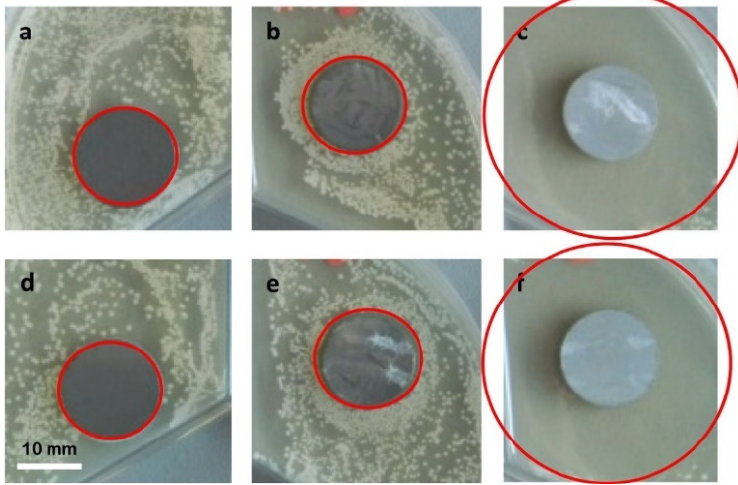
Figure 8. Bacterial inhibition tests after 24 h (direct contact, halo test) for: ( a ) bare SS sample with S. aureus , ( b ) chitosan–gelatin EPD coating on SS with S. aureus , ( c ) chitosan–gelatin-SiGe NPs EPD coating on SS with S. aureus , ( d ) bare SS sample with E. coli , ( e ) chitosan–gelatin EPD coating on SS with E. coli , and ( f ) chitosan–gelatin-SiGe NPs EPD coating on SS with E. coli . (Reprinted with permission from Ref [72]. Copyright 2020 Elsevier.)